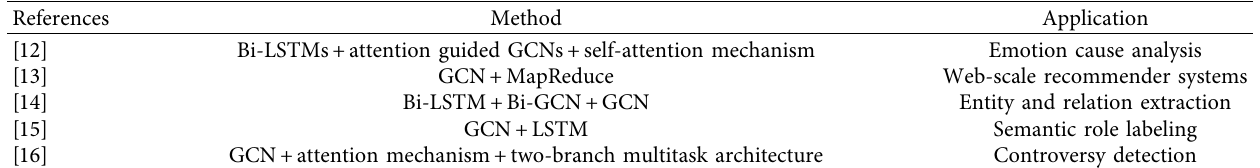
Table 1: Representative works on